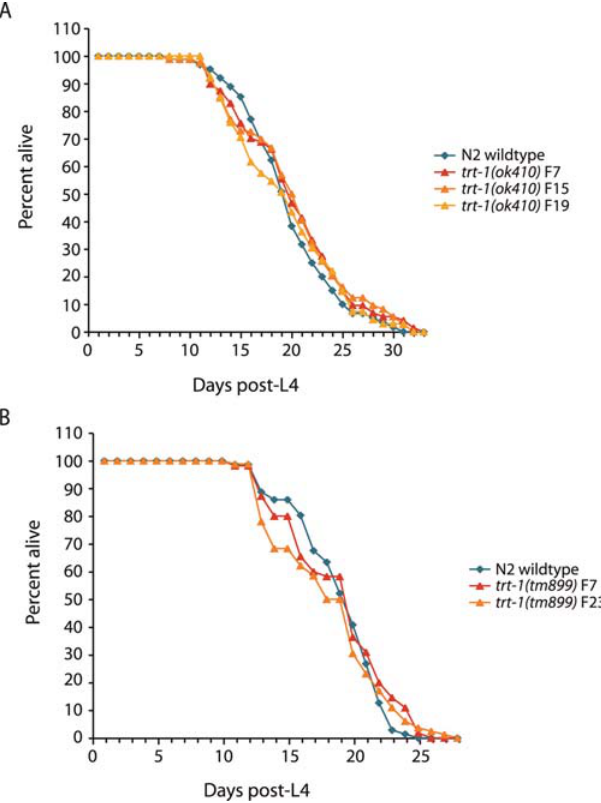
Figure 6. trt-1 Mutants Have a Normal Life Span Independent of Telomere Length and Telomere Uncapping (A) Life spans of N2 wild-type and early, middle, and late generations of a trt-1(ok410) strain. Mutants were analyzed at generations with slightly shortened telomeres (F7), short telomeres (F15), and very short telomeres with chromosome fusions (F19). (B) Life spans of N2 wild-type and early and late generations of a trt- 1(tm899) strain. DOI: